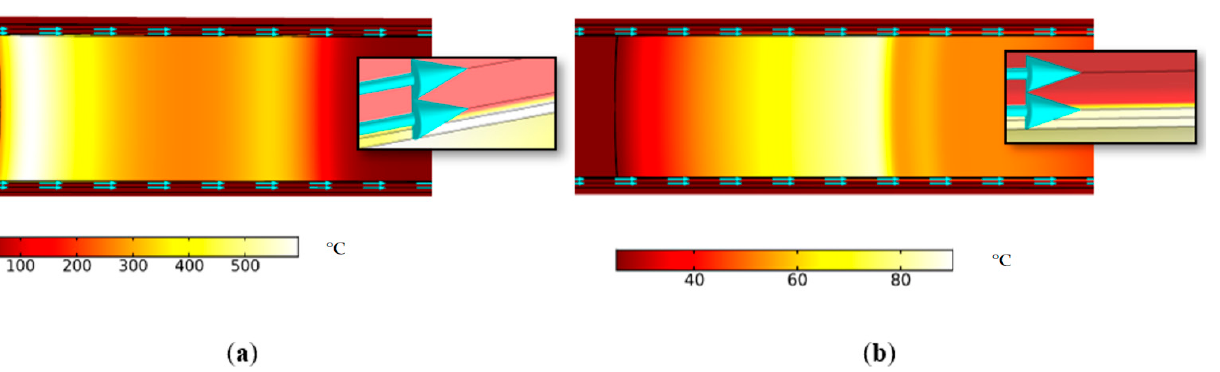
Figure 6. Thermal trace of the beam ( a ) in the presence of a polymer layer between the copper collector and the water-cooling system and ( b ) without the polymer layer.